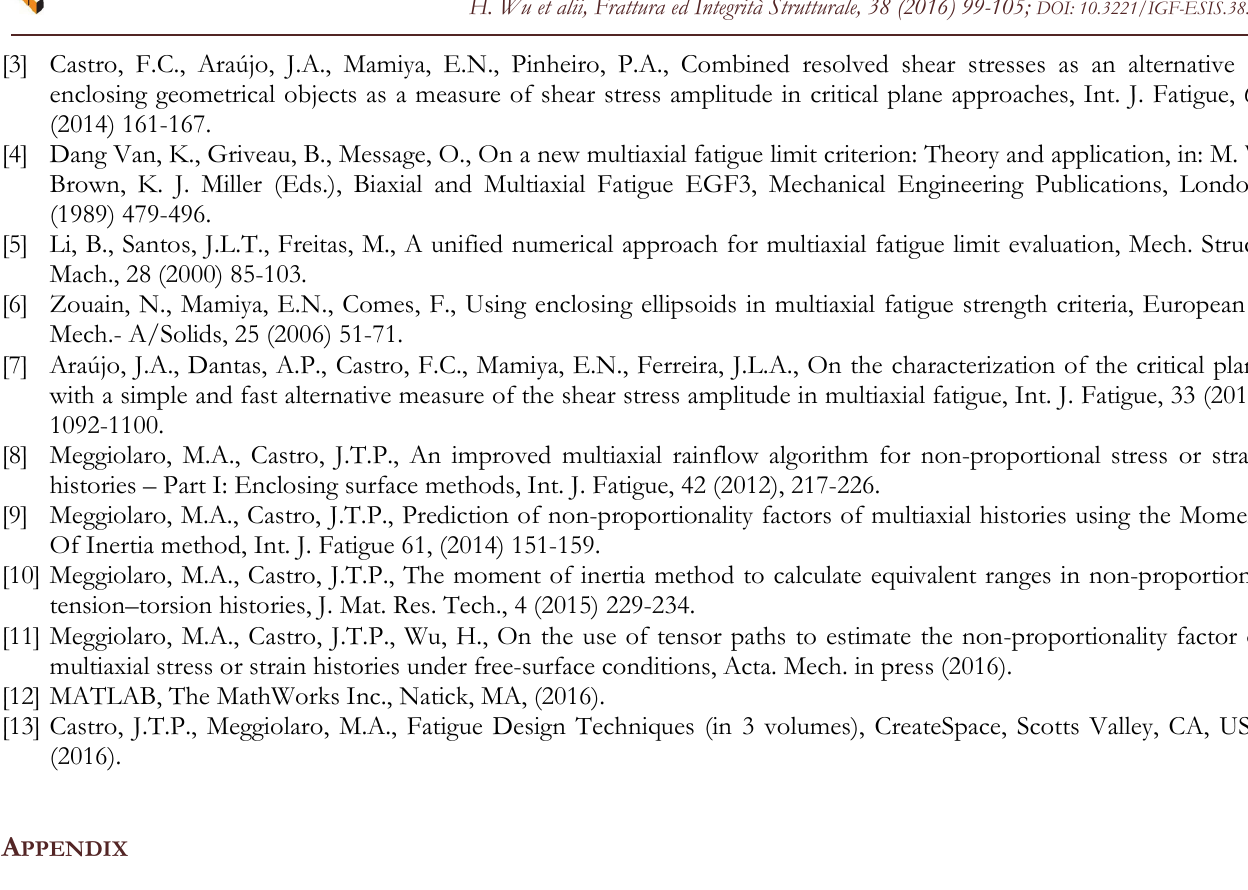
atlab implementation of the MOI method for a shear-shear stress history. For shear-shear strain histories, it is enough to replace all shear stress with shear strain